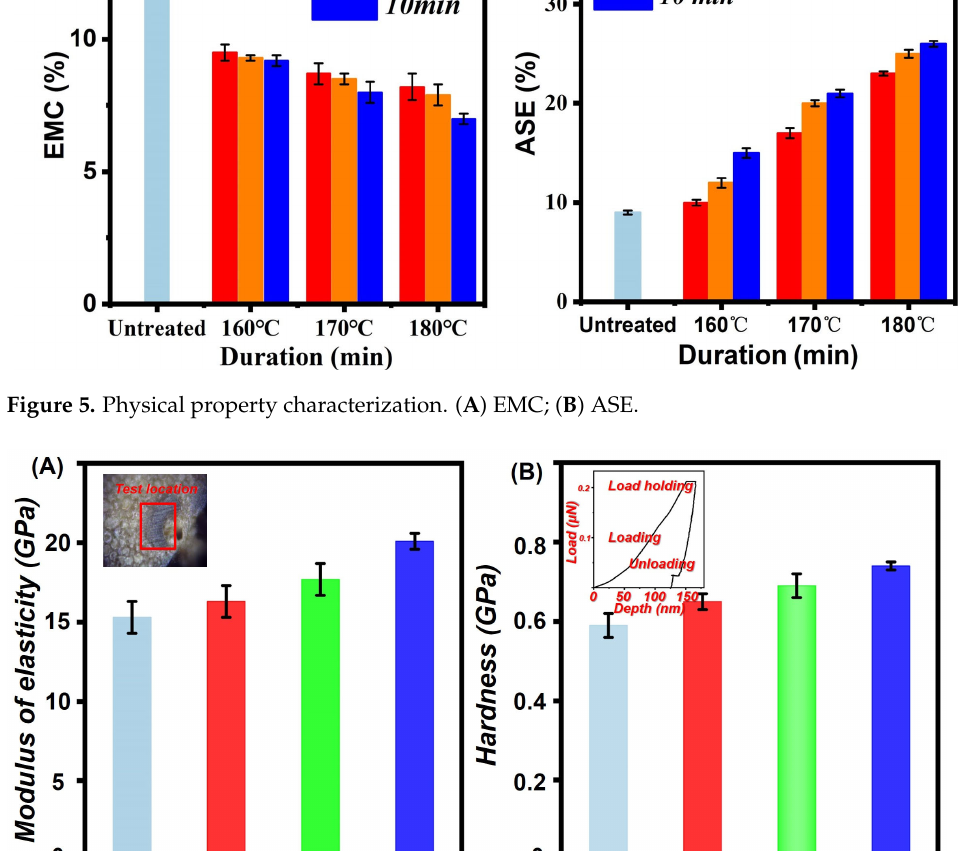
Figure 7. Micro ‐ mechanical property characterization. ( A ) Infection ratio in one month; ( B ) Picture of anti ‐ mold test in one month. 4. Conclusions By promoting greenhouse gas sequestration, bamboo and bamboo ‐ based products can improve carbon storage, and thus help decrease greenhouses gas emission through replacing traditional products like concrete, steel, and alloy. In summary, a green and